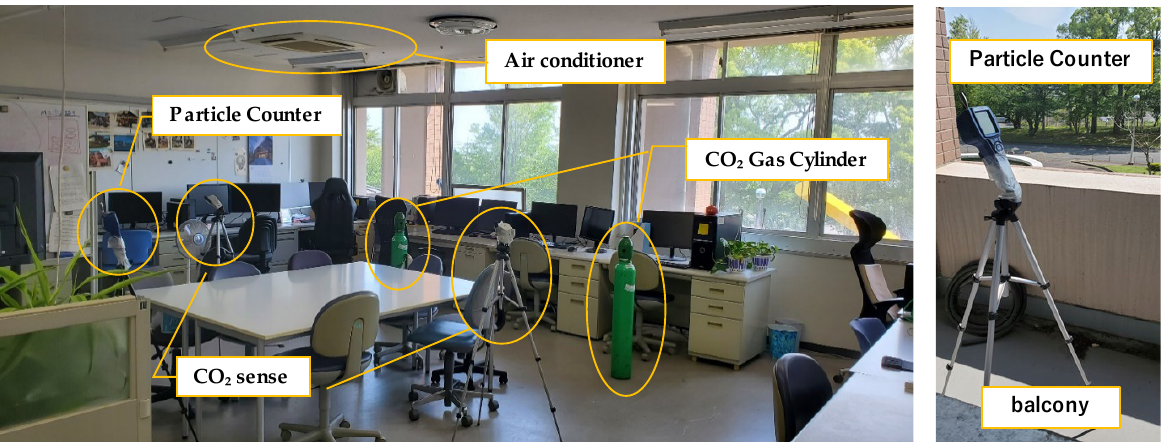
Figure 2. Indoor and outdoor measuring instruments.